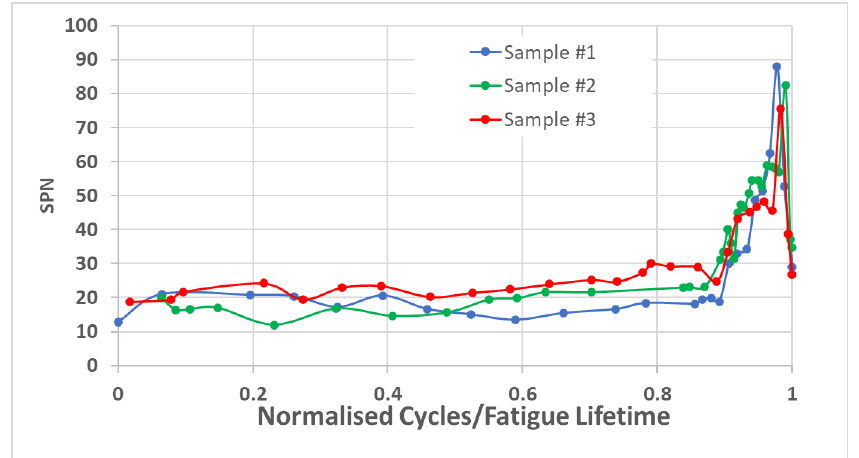
Figure 5. SPN versus the number of normalized cycles.